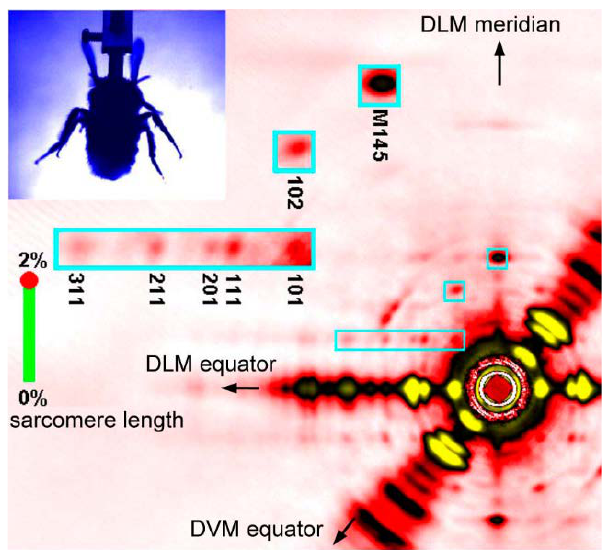
Figure 5. A single frame of X-ray diffraction movie recorded from the flight muscles of live, beating bumblebees (1 frame = 0.2 ms). The regions of interest (blue rectangles) are shown in a greater magnification on the left. Taken from Iwamoto & Yagi [46].